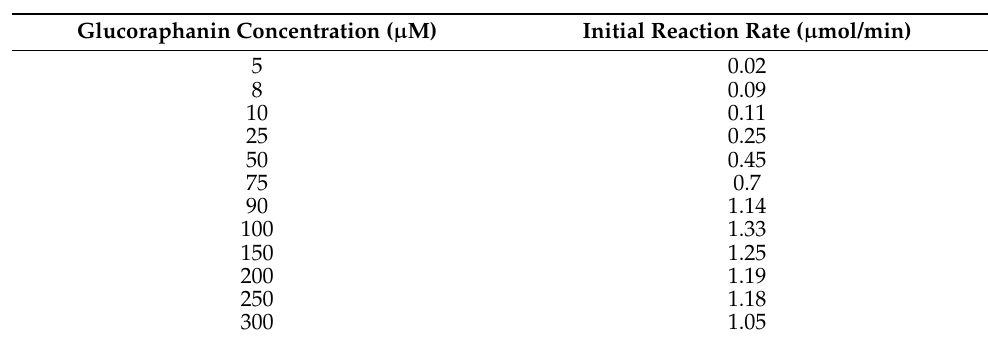
concentration graph [42]. Glucoraphanin Concentration ( µ